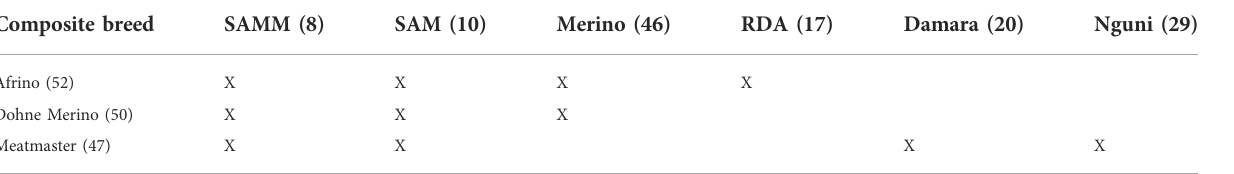
TABLE 1 South African Merino-derived breeds and their ancestral